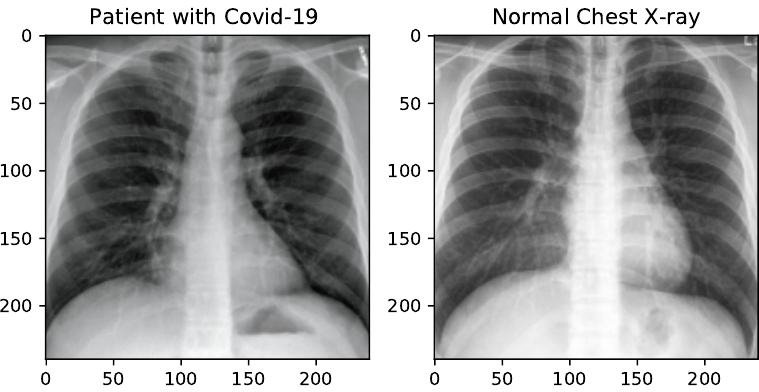
Figure 2. X-ray image samples of two categories after image manipulation.